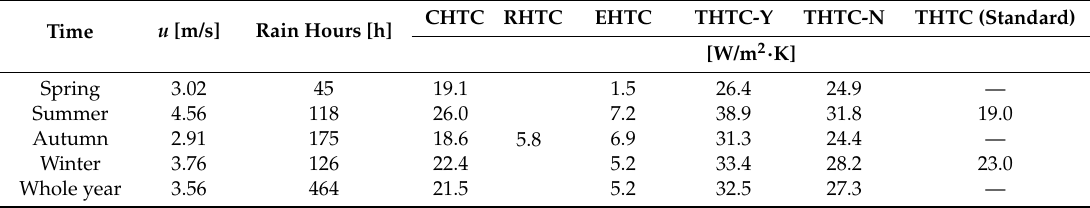
Table 3. Heat transfer coefficients of different seasons in the tropical island